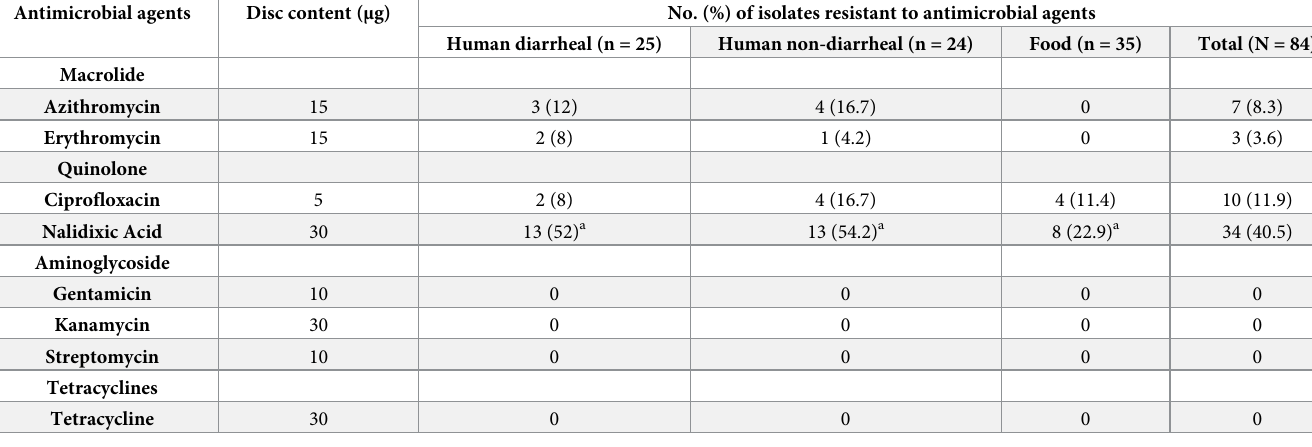
Table 1. Resistance to antimicrobial agents of Arcobacter butzleri isolates from human diarrheal and non-diarrheal stool and food samples. Antimicrobial agents